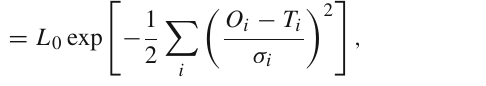
correspond to the best fit and lower/higher 2 σ extreme values of the parameter δ in Table 1. The red solid line corresponds to the (cid:2) CDM model, and the error bars represent the observational